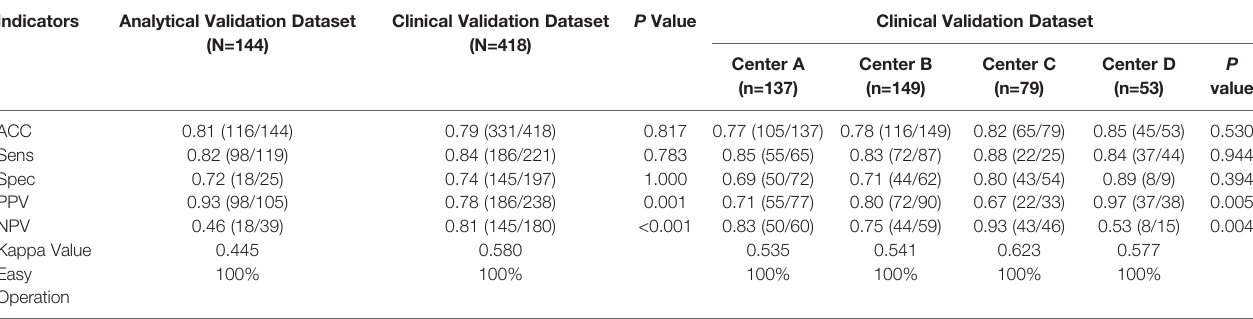
TABLE 2 | The diagnostic ef fi cacy and ease of operation evaluation of electrical impedance analysis by different clinical centers.